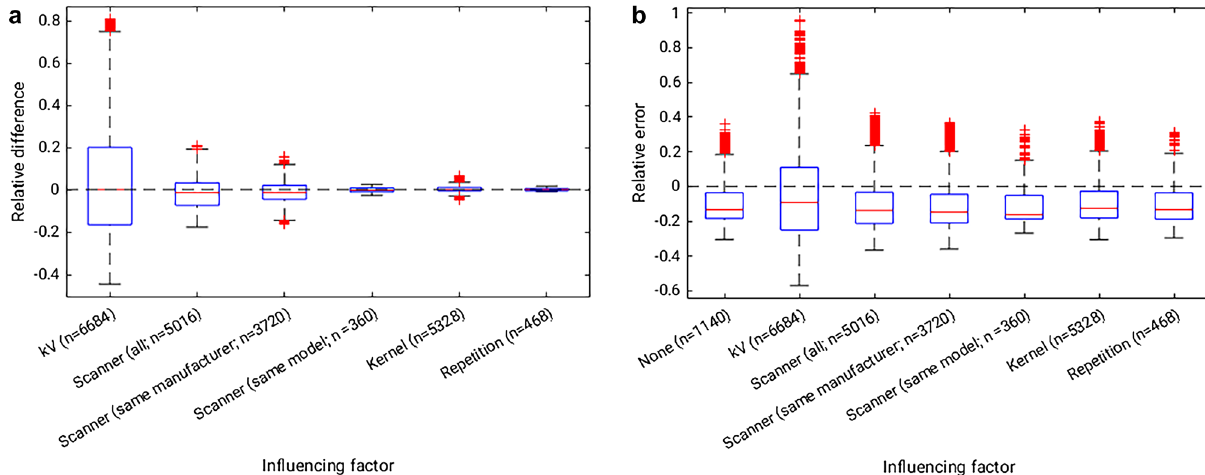
Figure 3. ( A ) Relative difference between calculated bone mineral density values when varying the reference value used for the calculation. “Scanner (all)” refers to using matching reference values (i.e. same tube voltage and similar reconstruction kernel) from any of the other scanners. ( B ) Relative error compared to ground truth when varying the reference value used for the calculation, compared to the value calculated when using the actual reference value (Influencing factor: “None”).